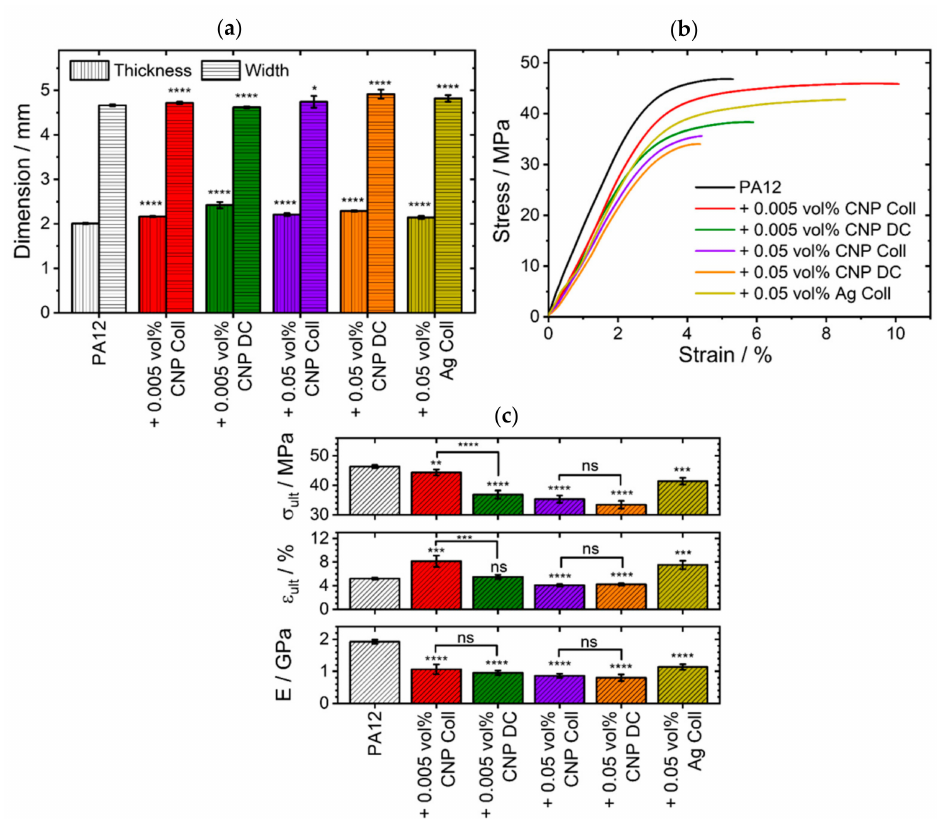
Figure 6. The overview of the tensile test results shows the LB-PBF-P specimens of different material compositions with regard to their ( a ) measured dimensions, ( b ) exemplary stress–strain curves, and ( c ) mechanical properties of the ultimate tensile strength ( σ ult ), ultimate elongation ( ε ult ) and Young’s modulus ( E ). The level of significance increases with the number of asterisks, while “ns” stands for an insignificant